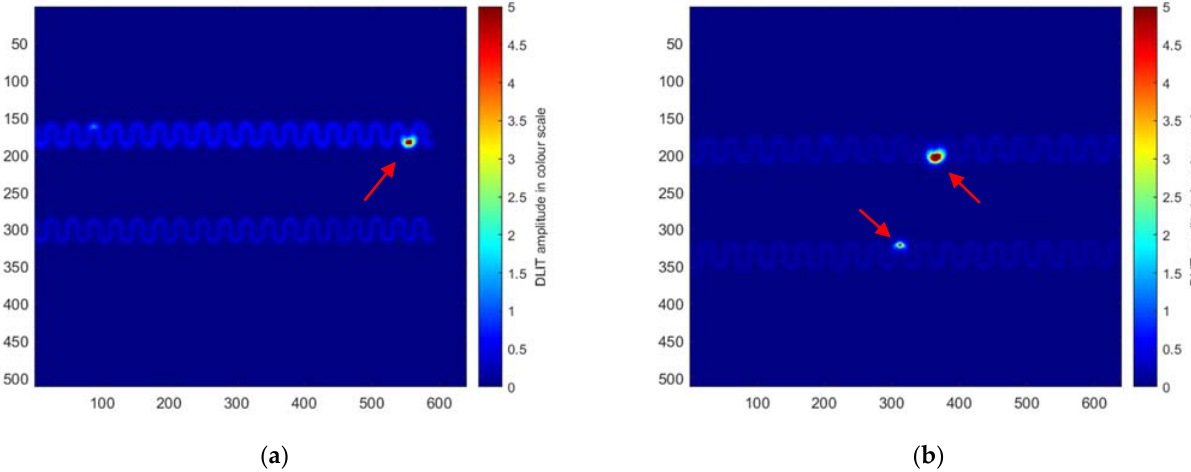
Figure 10. DLIT amplitude images of ( a ) Test Sample 3 and ( b ) Test Sample 4.